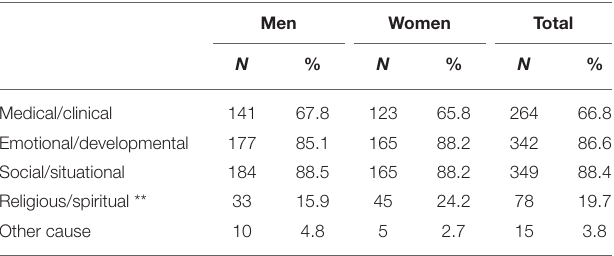
TABLE 8 | Frequency and percentage for types of illness explanations for mental health problems, by